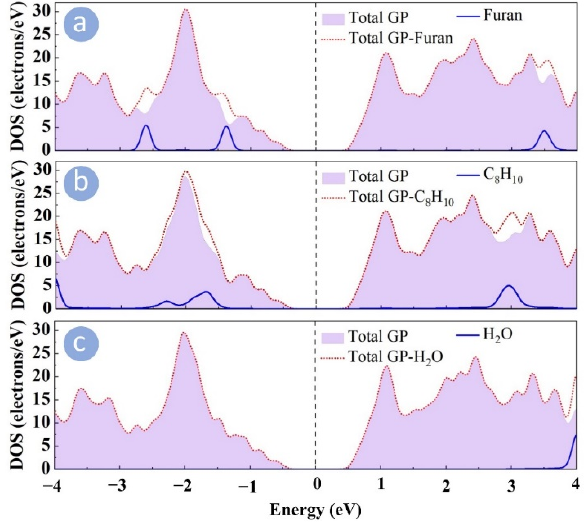
Figure 4. DOS plots for pristine GP sheet exposed to ( a ) furan, ( b ) C 8 H 10 , and ( c ) H 2 O molecules.